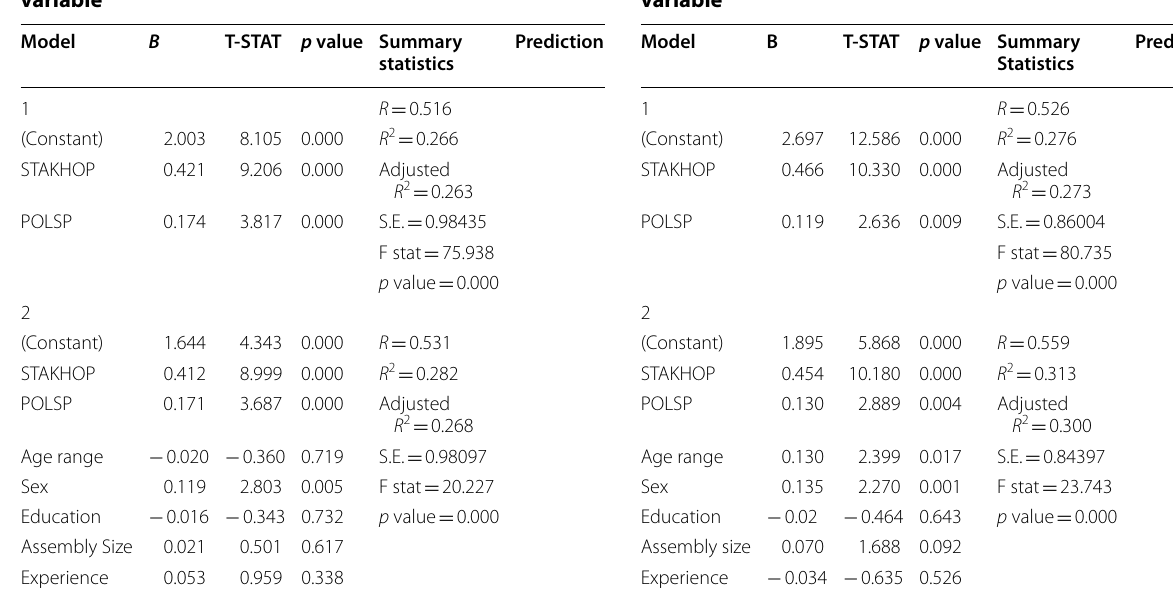
Table 8 Regression results with PEREV as a dependent variable